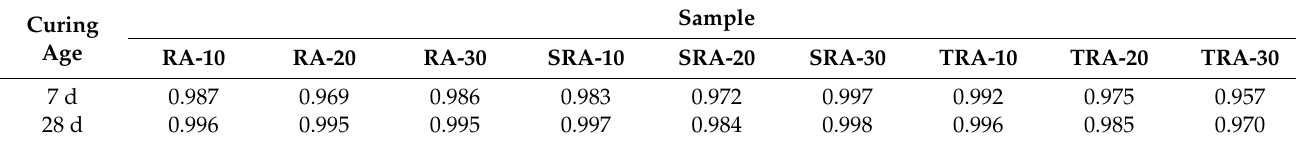
Table 7. Brittleness index of samples with different contents of recycled